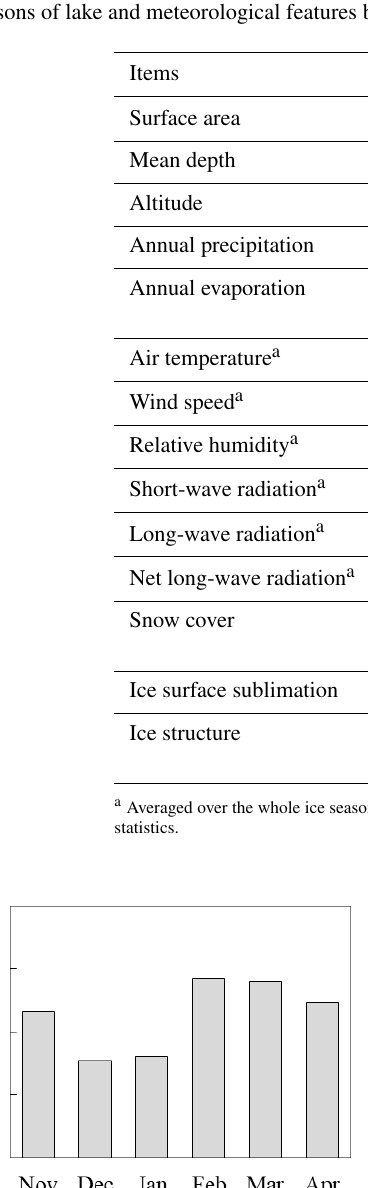
Table 4. Comparisons of lake and meteorological features between Lake BLH-A and an Arctic lake (Lake Orajärvi).